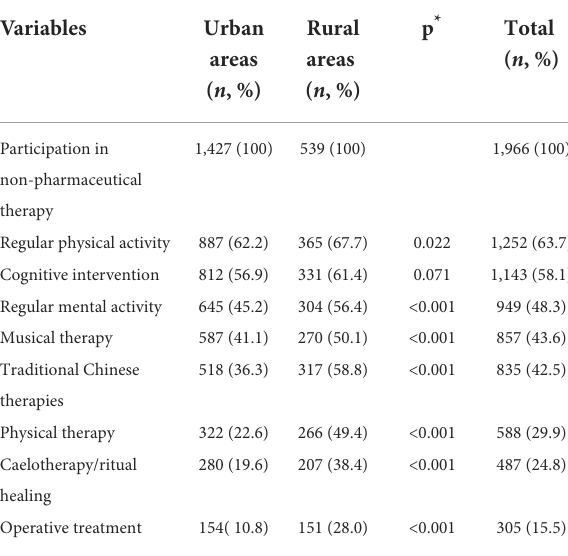
TABLE 3 Binary logistic regressions of medication adherence among the urban and rural people with